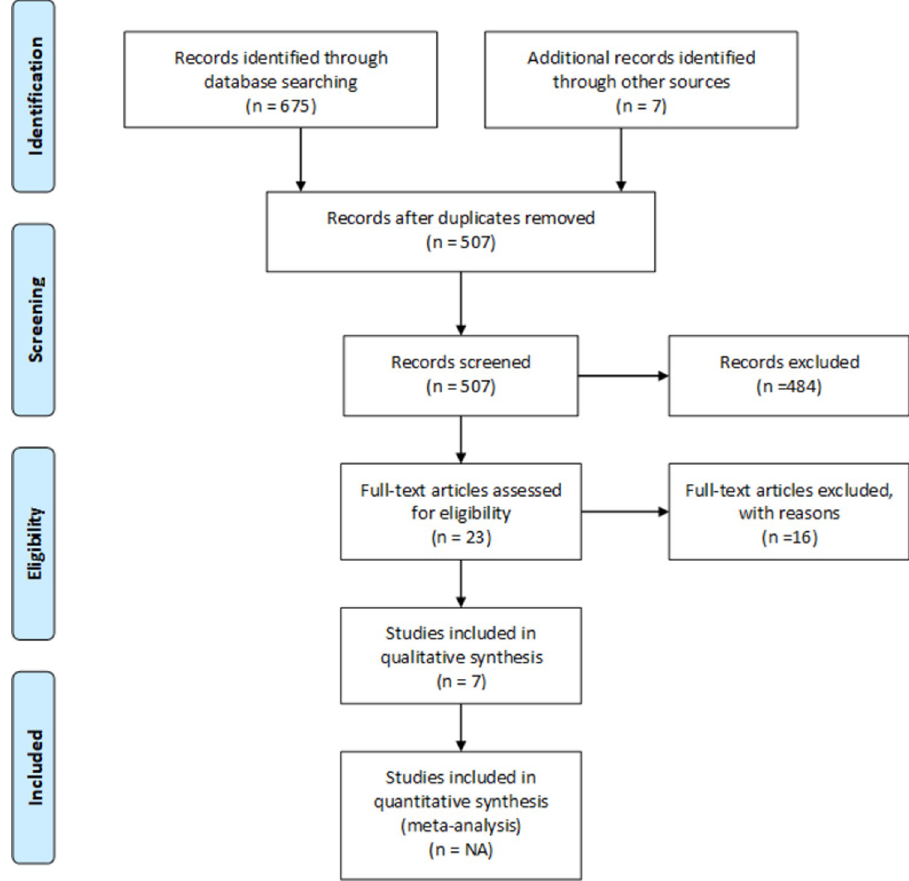
Fig 1. PRISMA flow diagram indicating the selection process for articles identifying risk factors of complicated grief for family members of ICU decedents.